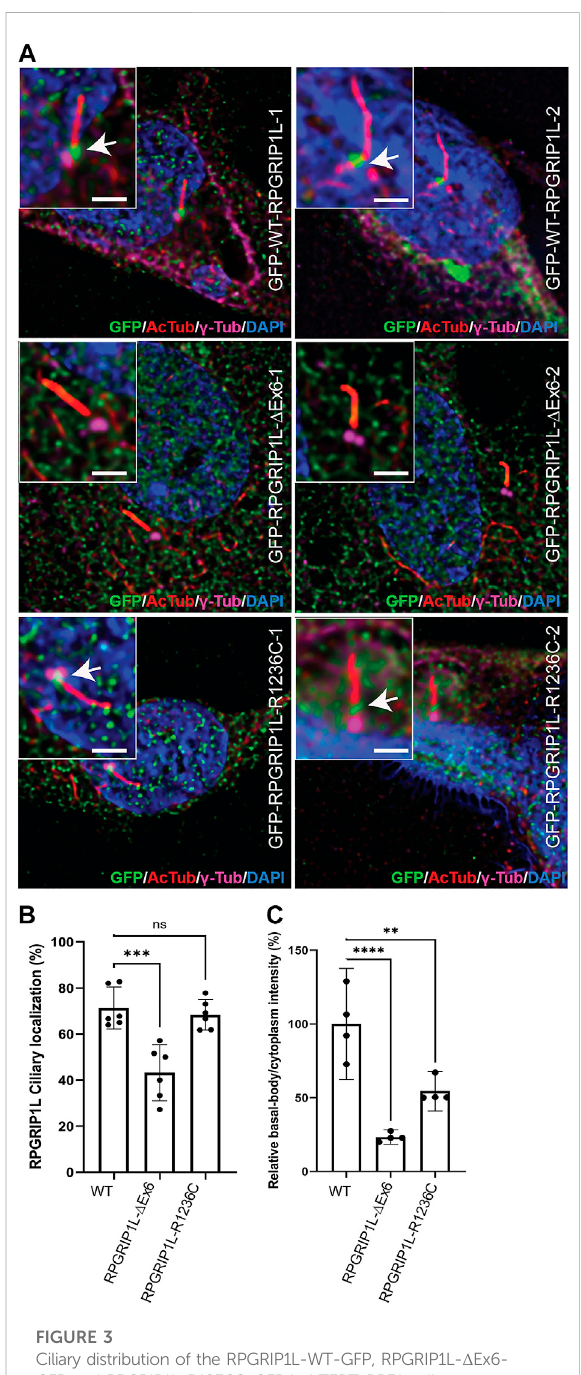
FIGURE 3 Ciliary distribution of the RPGRIP1L-WT-GFP, RPGRIP1L- Δ Ex6- GFP and RPGRIP1L-R1236C-GFP in hTERT-RPE1 cells. (A) Immunostaining of the ciliary markers acetylated-tubulin (red) and γ -tubulin(magenta)showingtheabsence(RPGRIP1L- Δ Ex6-GFP, green) or reduction (RPGRIP1L-R1236C-GFP, green) of the mutant RPGRIP1L localization at the cilia. Insets show the localization of RPGRIP1L to the proximal transition zone region of the cilium.